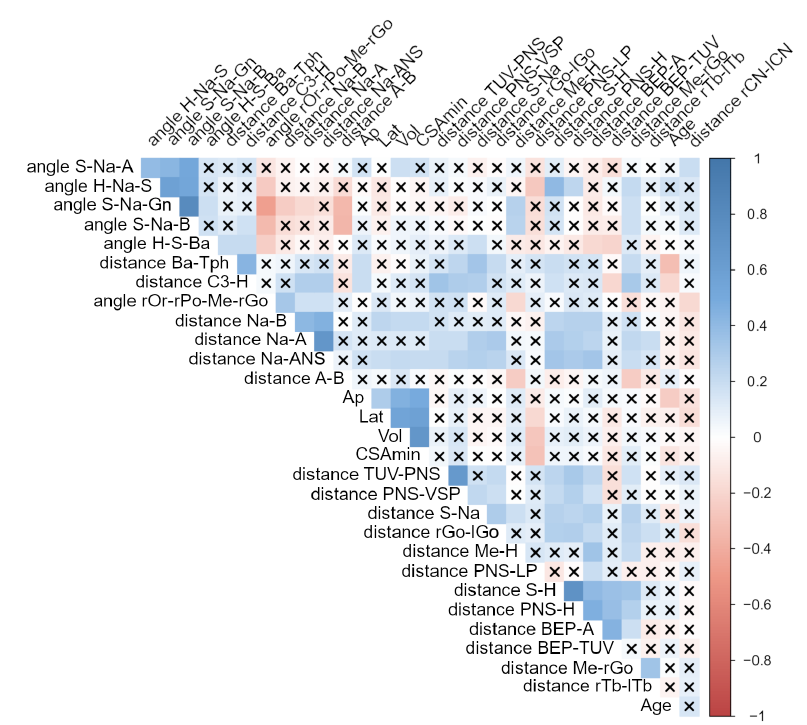
Figure 1. The correlation matrix plot between the variables two by two using Kendall’s τ correlation coefficient. The level of significance was set at 5% ( p < 0.05). The colormap indicates the values of the correlation (from strong positive correlation in deep blue to strong negative correlation in deep red). A cross means non-significance at the 5% threshold.